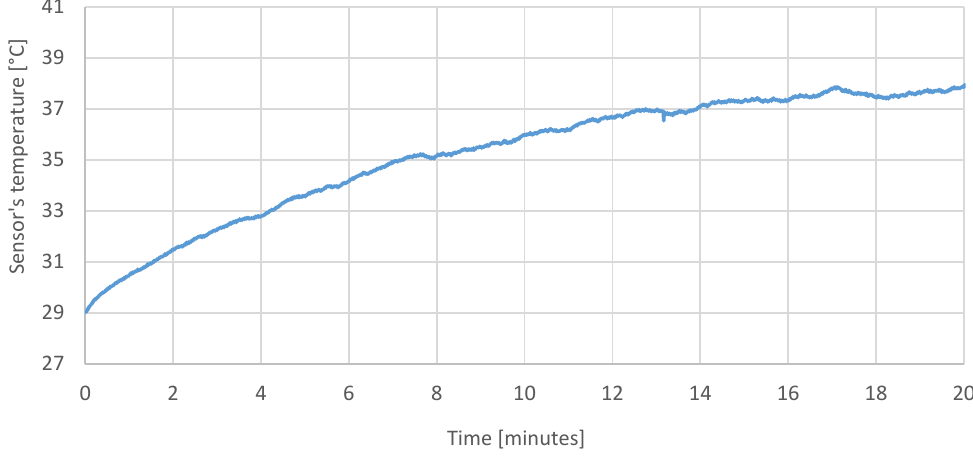
Figure 15. Sensor temperature during the test.